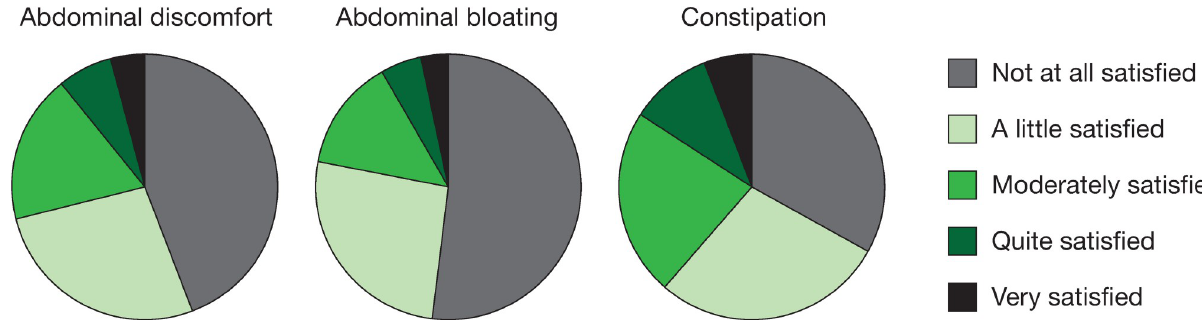
Fig 1. Patient satisfaction with OTC medication’s ability to relieve symptoms. Abbreviation: OTC = over-the-counter.